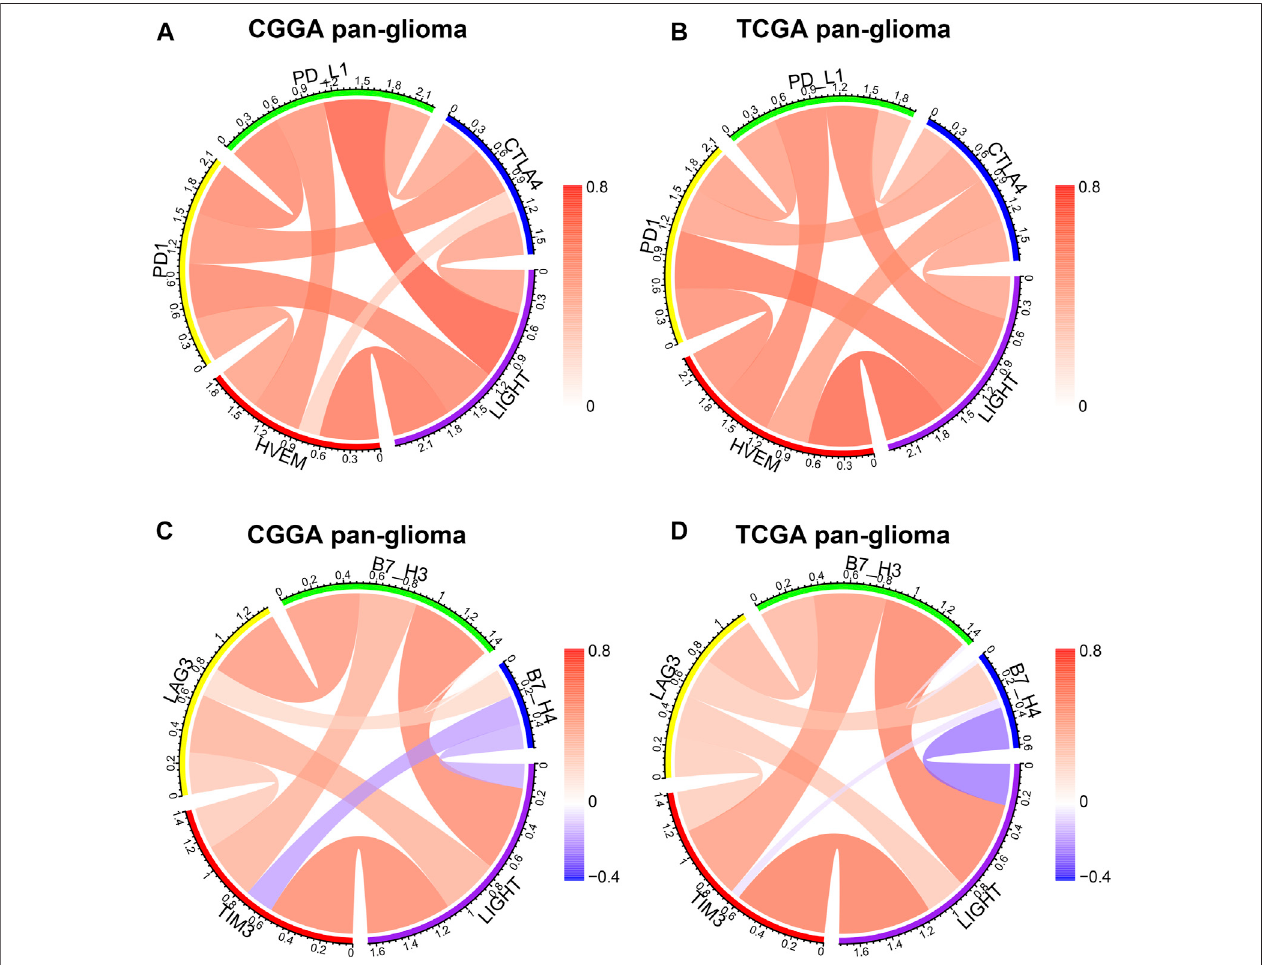
FIGURE 3 | Correlation of LIGHT and immune checkpoint members in pan-glioma. Correlation of LIGHT and HVEM, PD1, PD-L1, CTLA4 (A, B) . Correlation of LIGHT and TIM3, LAG3, B7-H3, B7-H4 (C, D) .